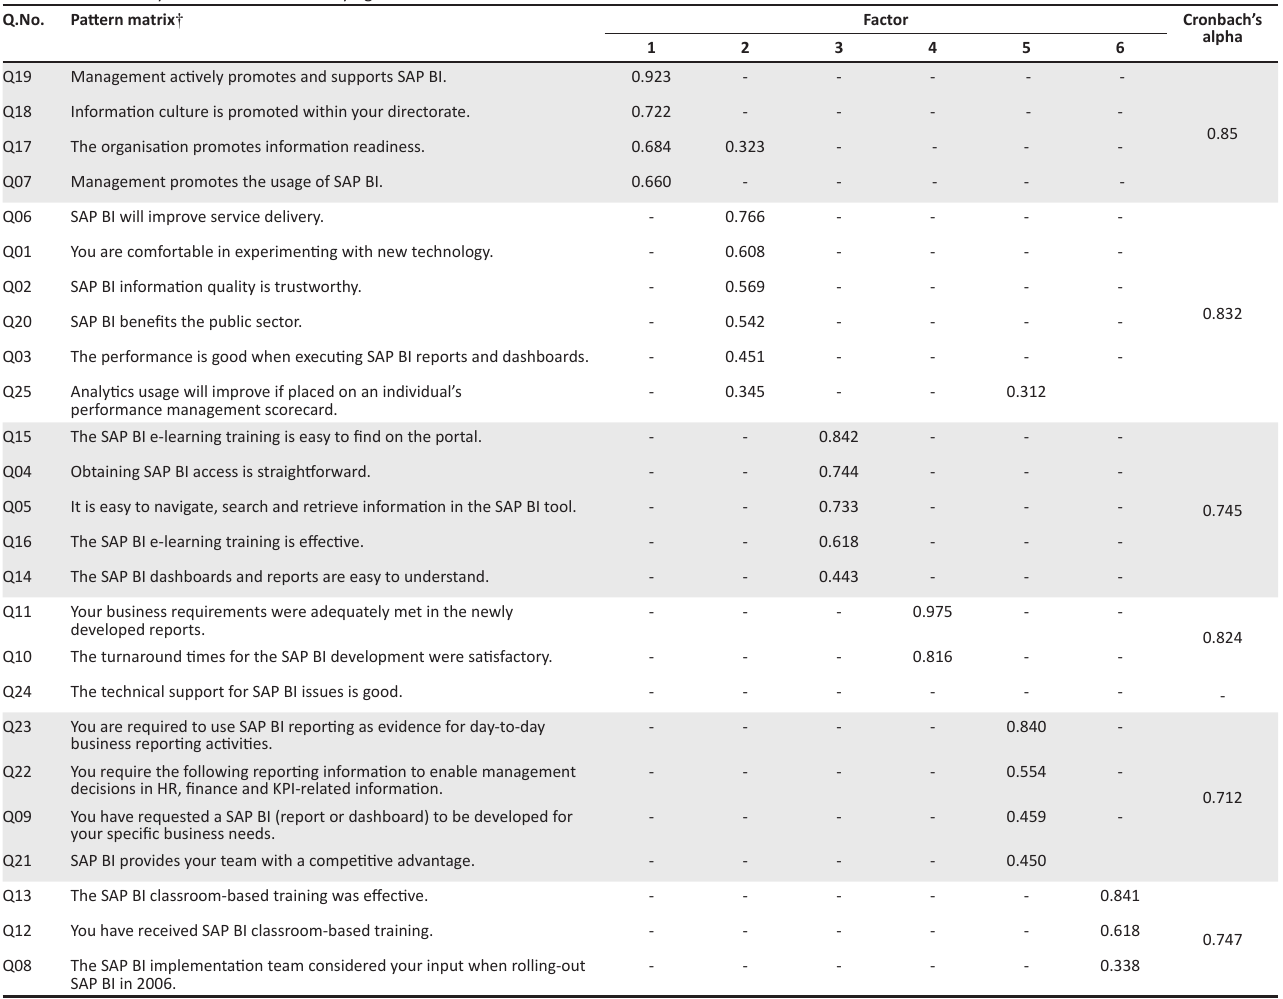
TABLE 3: Factor analysis to determine underlying themes.